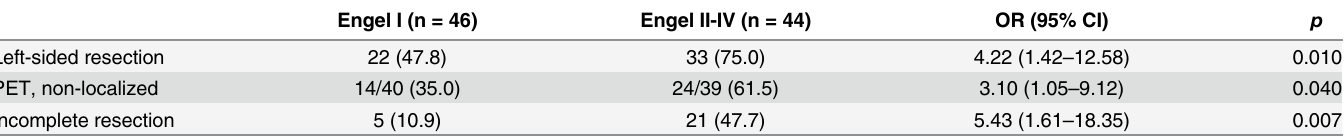
Table 5. Prognostic factors of seizure outcomes at the last follow-up.